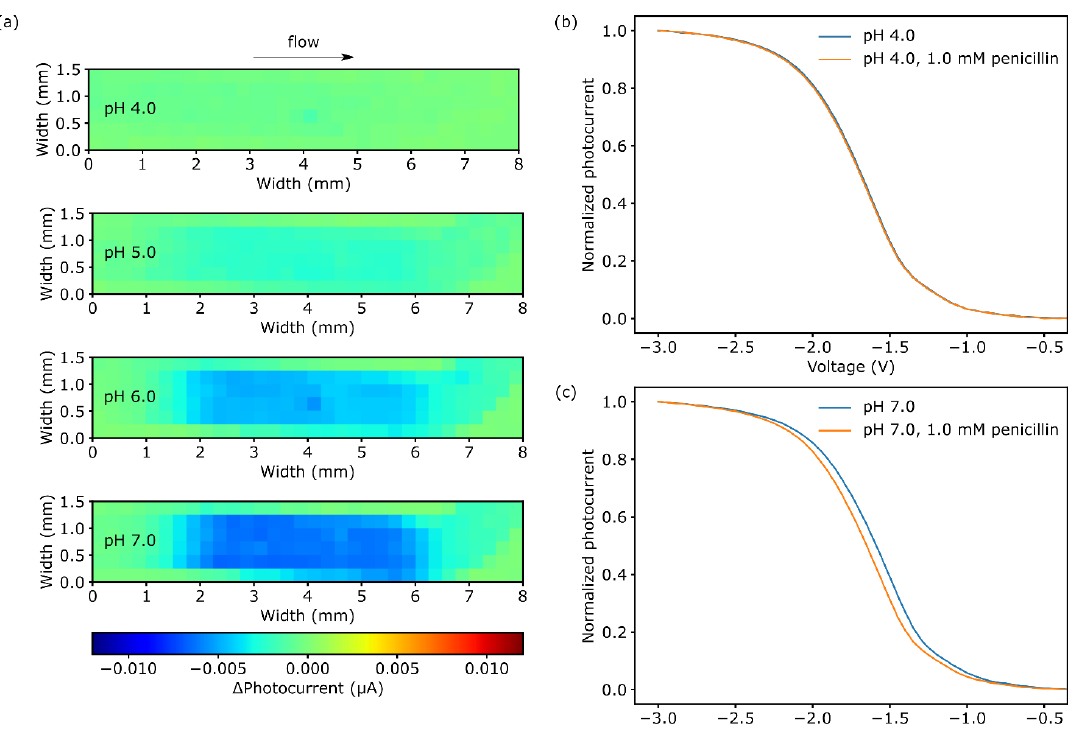
Figure 4. ( a ) Chemical images for 1.0 mM penicillin in pH 4 to pH 8 PBS buffer after 5 min of enzymatic reaction. Photocurrent-voltage curve for ( b ) pH 4 and ( c ) pH 8 PBS buffer with and without 1.0 mM penicillin.